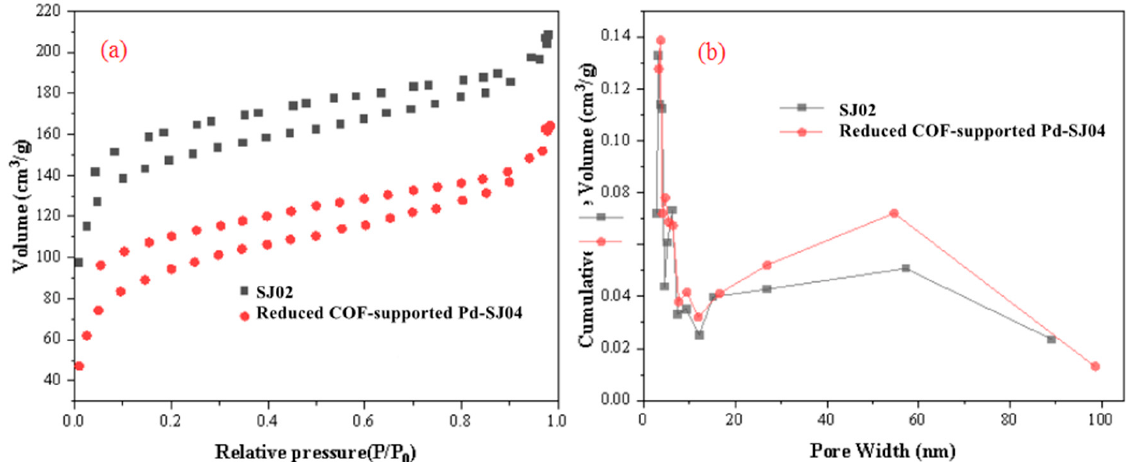
Figure 3. ( a ) Nitrogen adsorption–desorption isotherms and ( b ) pore size distribution of SJ02 and reduced COF-supported Pd-SJ04.